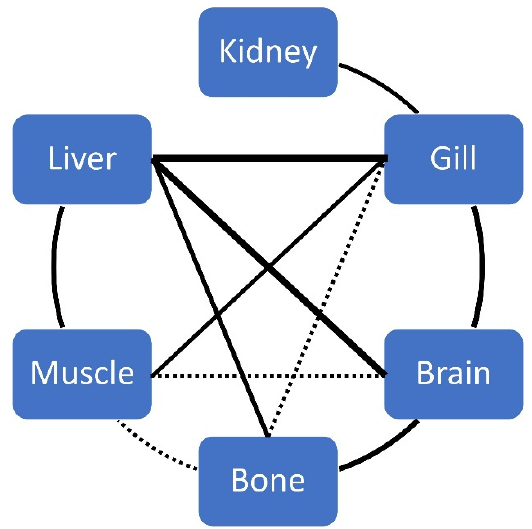
Figure 4. Correlations between tissues for THg concentration in ABFT. The solid line indicates a p-value < 0.01, and a dashed line indicates a p-value < 0.05. The thickness of the line represents the strength of the relationship.